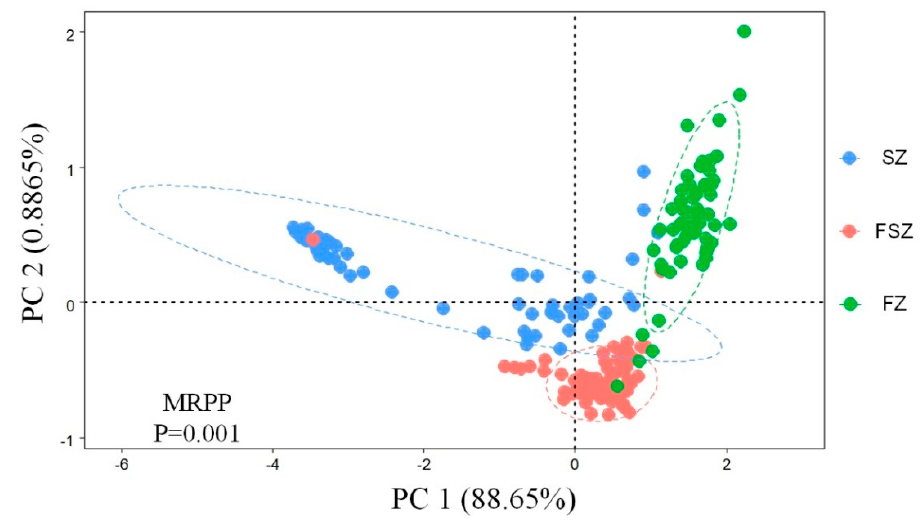
Figure 7. The di ff erence of soil particle size distribution in di ff erent vegetation zones. Table 1. Significance and percentage contribution of the factors’ e ff ects on the multifractal dimensions of soil particle size distribution and soil erodibility based on univariate analysis of variance. D0: capacity dimension; D1: information dimension; D1 / D0: information dimension / capacity dimension ratio; D2: correlation dimension.